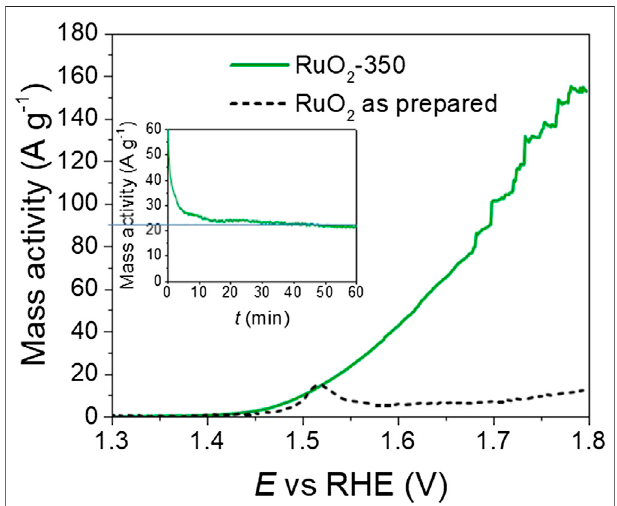
FIGURE 7 | Linear scan voltammograms for oxygen evolution reaction (OER) on H-RuO 2 (dashed lines) and C-RuO 2 sample (green line) recorded in 0.50 mol L − 1 H 2 SO 4 at a scan rate s (cid:2) 0.010 V s − 1 and T (cid:2) 25 ° C. Inset: chronoamperometric curves for the C-RuO 2 recorded at E (cid:2) +1.600 V vs. RHE.